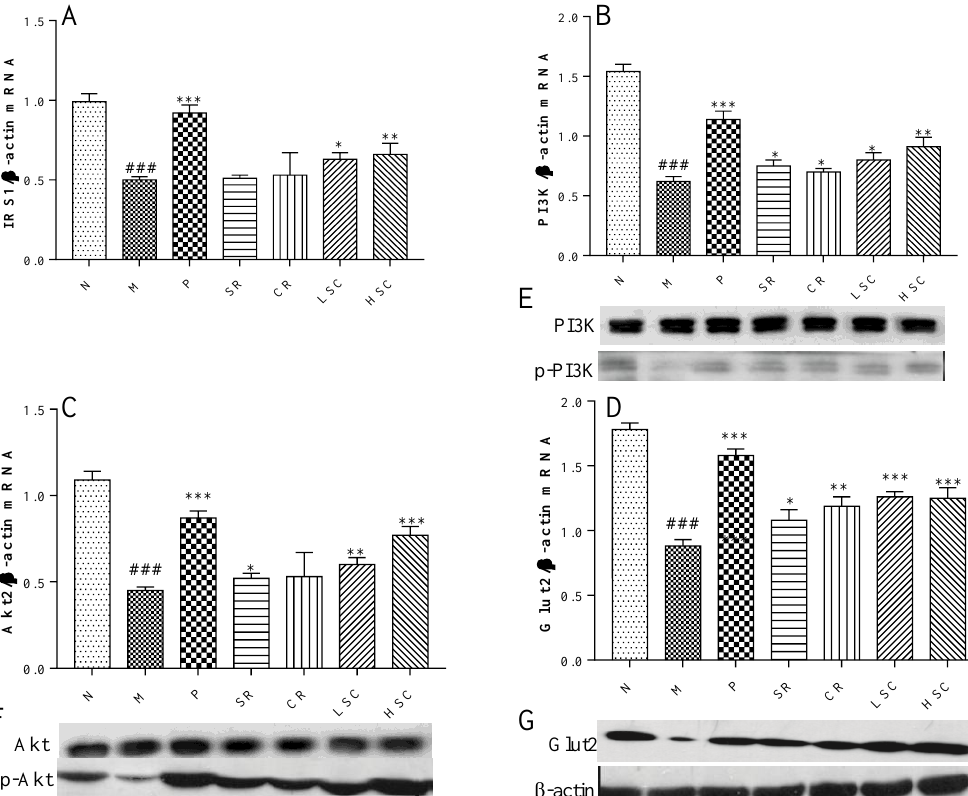
Figure 5. The effect of metformin (P), scutellaria Radix (SR), coptidis Rhizome (CR), low dose of combined extracts group (LSC) and high dose of combined extracts (HSC) on insulin signaling pathway. ( A – D ) mRNA expression levels of Insulin receptor substrate 1 (IRS1), Phosphatidylinositol-4,5-bisphosphate 3-kinase (PI3K), Protein kinase B (Akt2) and Glucose transporter 2 (Glut2) in liver of the N, M, P, SR, CR, LSC, and HSC by qPCR; ( E – G ) Protein expression levels of PI3K, phosphorylated PI3K (p-PI3K), Akt2, phosphorylated Akt2 (p-Akt2), Glut2 in liver of the N, M, P, SR, CR, LSC, and HSC by Western blot. The values are shown as mean ± SD. # p < 0.05, ## p < 0.01, ### p < 0.001 vs. normal group; * p < 0.05, ** p < 0.01, *** p < 0.001 vs. model group. Data were analyzed by One-way-ANOVA.